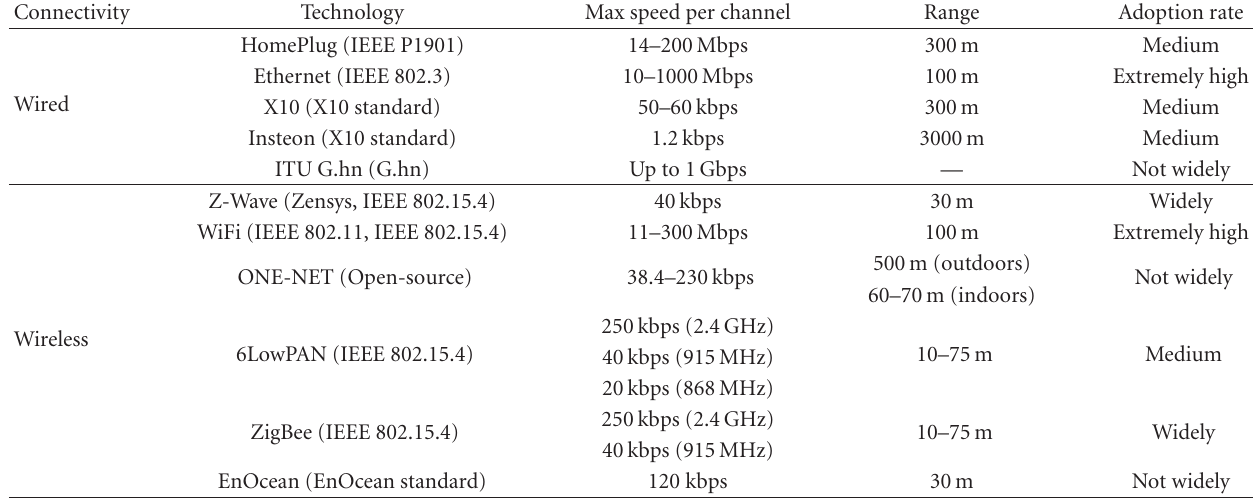
Table 2: Summary of communications and networking technologies for home area